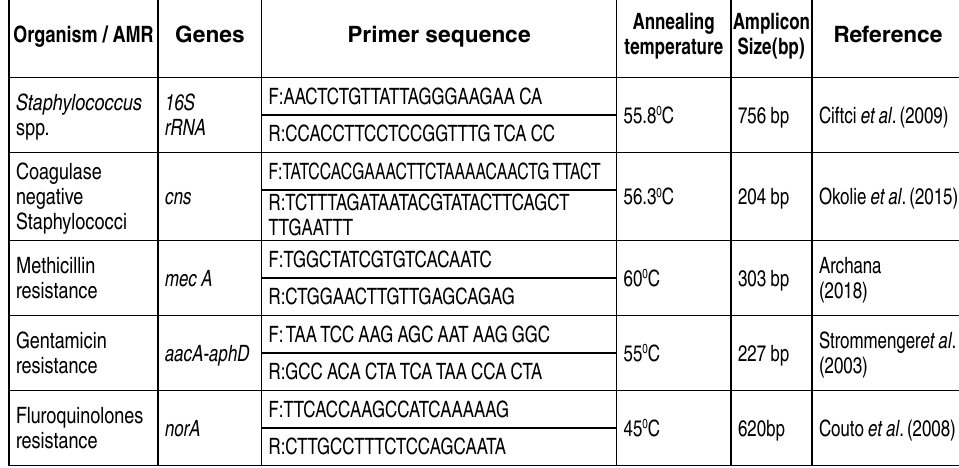
table 1. Details of primers and conditions used for